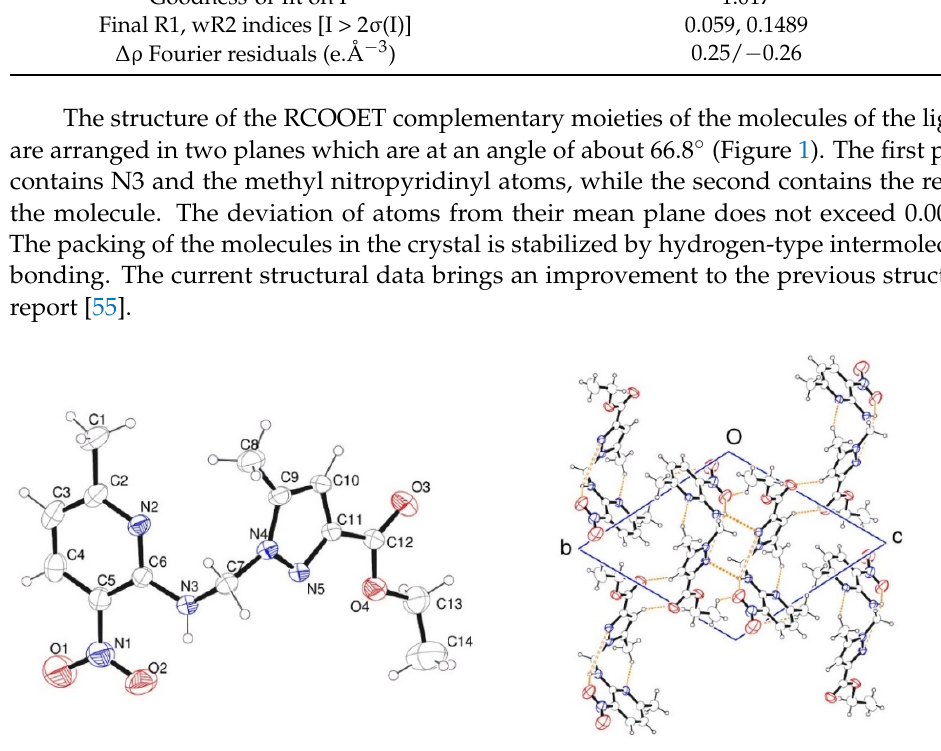
Figure 1. Ortep representation of RCOOET(the free ligand) and packing in the triclinic cell.